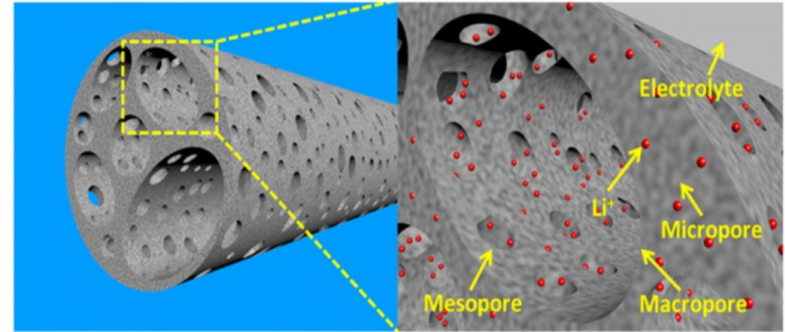
Figure 4. Scheme of the porous structure and Li + storage system. Figure reproduced from reference [67] with permission from Royal Society of Chemistry.